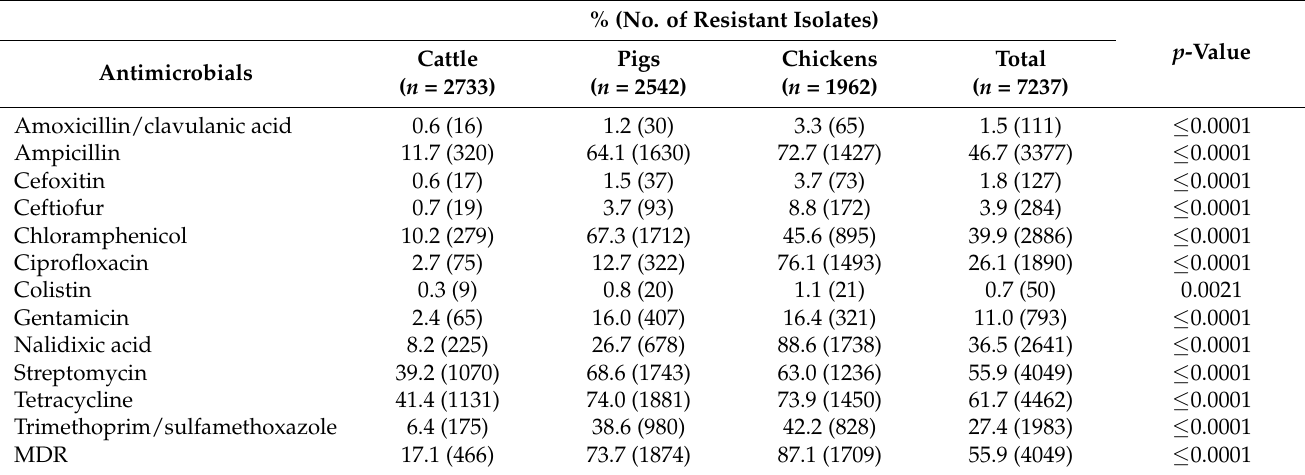
Table 2. Antimicrobial resistance of E. coli isolated from healthy cattle, pigs, and chickens during